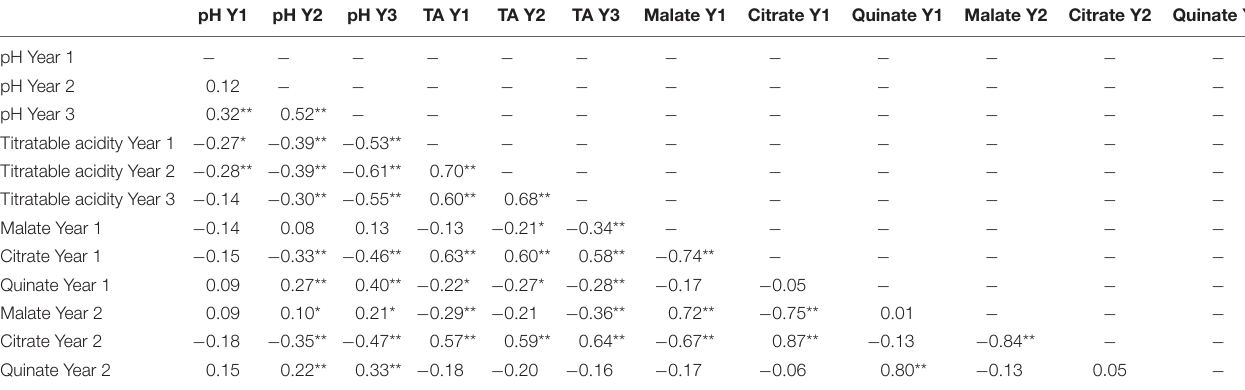
TABLE 2 | The Pearson’s correlation coefficients between pH, titratable acidity (TA), citrate, quinate, and malate content calculated on 90 individuals of the ‘Lito’ × ‘BO81604311’